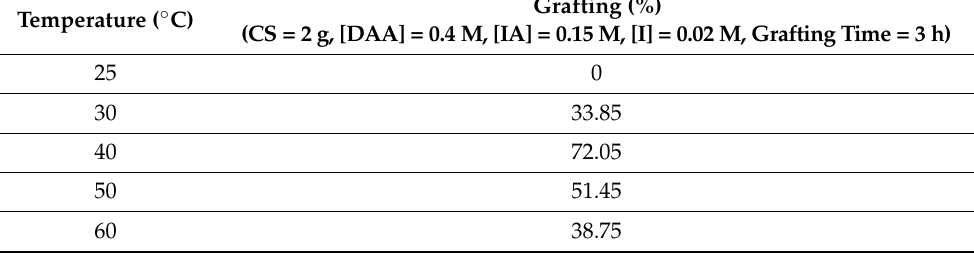
Table 4. Effect of temperature on the graft percentage.